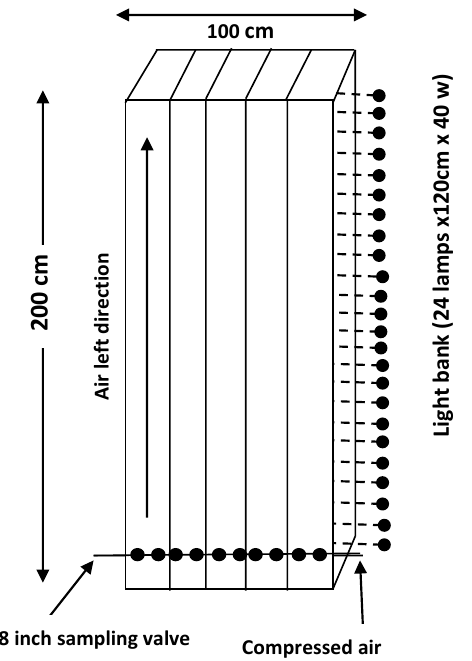
Fig. 1. Open sheet (200 L) photobioreactor